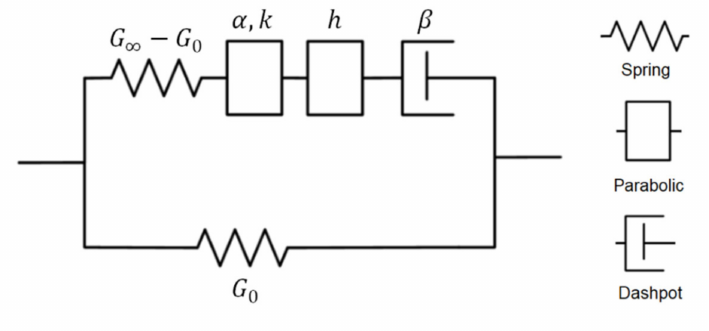
Figure 1. Schematic representation of the 2S2P1D rheological